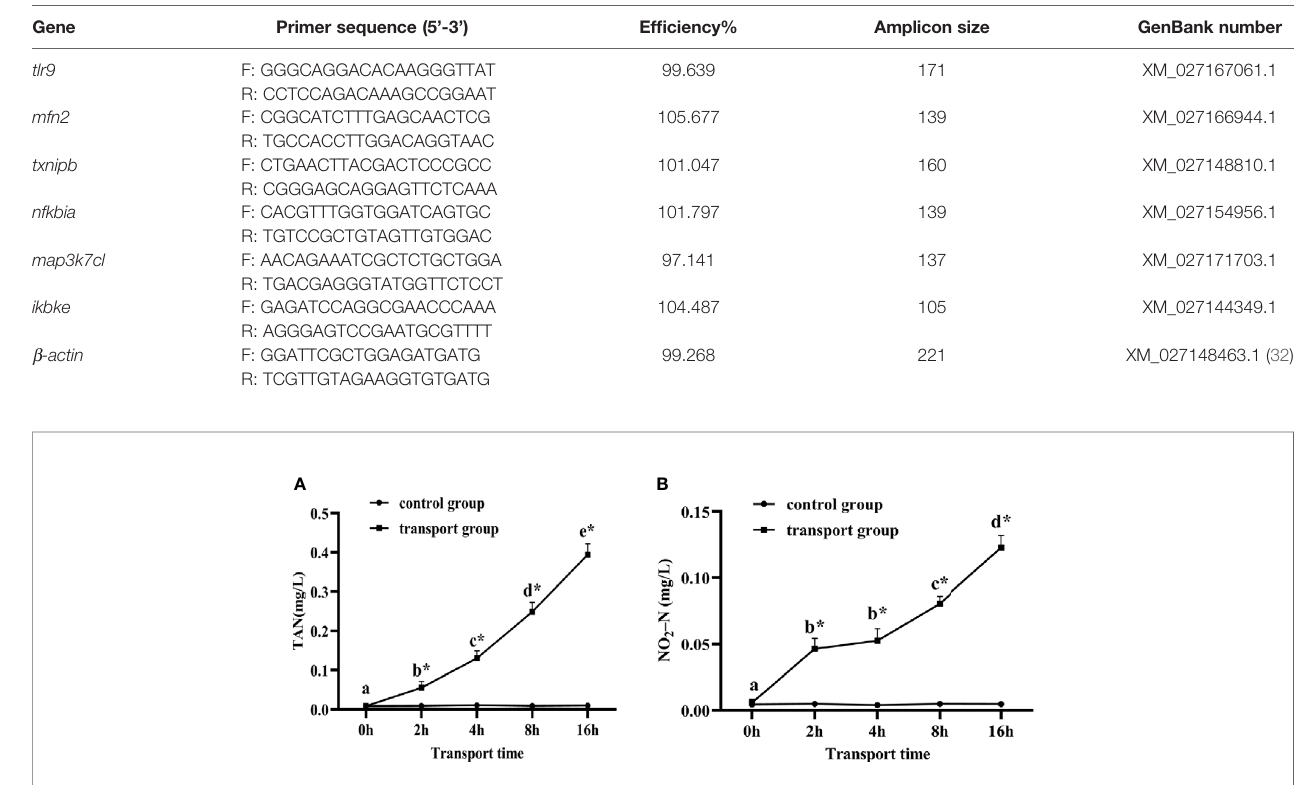
TABLE 1 | The speci fi c primer sequences for qPCR in this study.